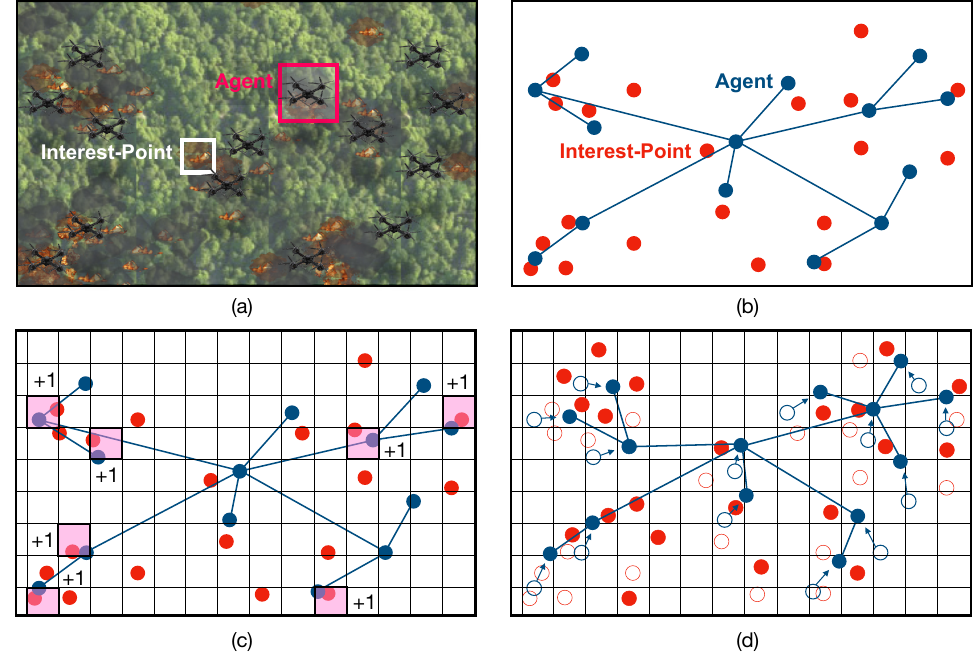
Figure 3: A Markov Decision Process framework for tracking the spread of forest fires. (a) Burning Figure 1. A multi-UAV tracking scenario. ( a ) Burning trees and UAVs correspond to interest-points trees are interest points and UAVs are agents. (b) The system of agents coordinate to visit as many and agents respectively. ( b ) The system must coordinate to visit as many interest-points as possible interest-points as possible in the shortest possible time frame. (c) The system state specifies the in the shortest possible time. ( c ) The system state specifies the locations of agents and interest-points. instantaneous locations of agents and interest points. The reward for a state is determined by the The reward for a state is determined by the number of agents that coincide with number of agents that coincide with interest-points. (d) Interest-points evolve over time, so agents must communicate with each other to coordinate their activity and maximize their reward.